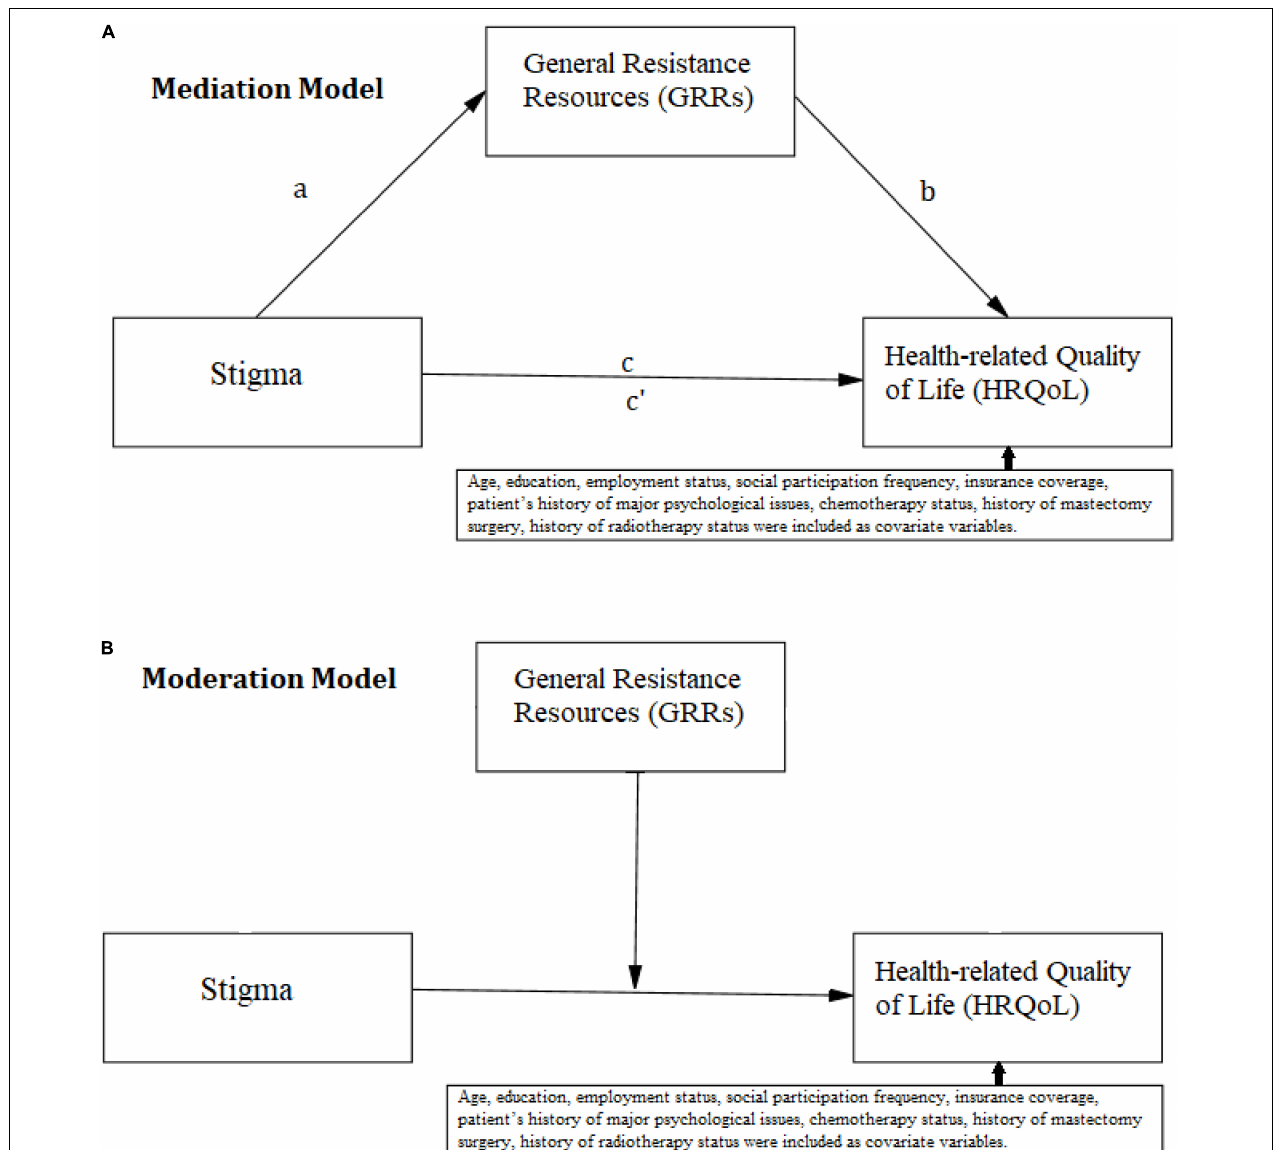
FIGURE 1 | Conceptual model for (A) mediation analysis, (B) moderation analysis, including the covariate